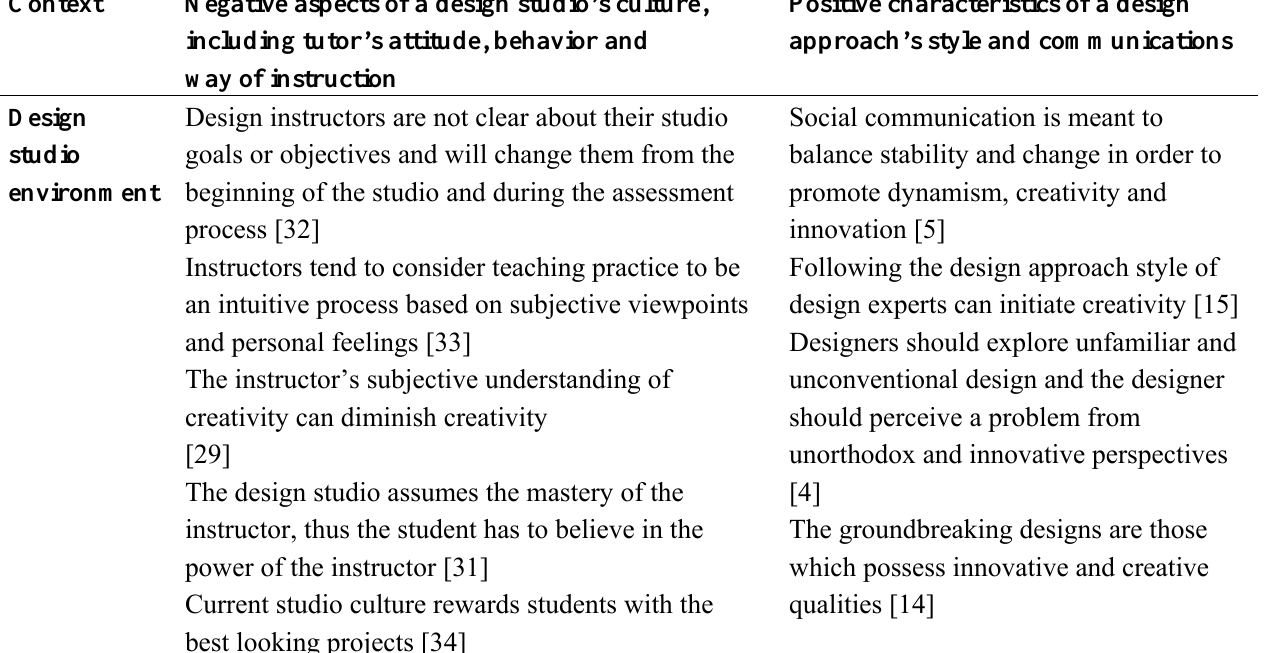
Table 1. Potential hindrances to, and initiatives for,